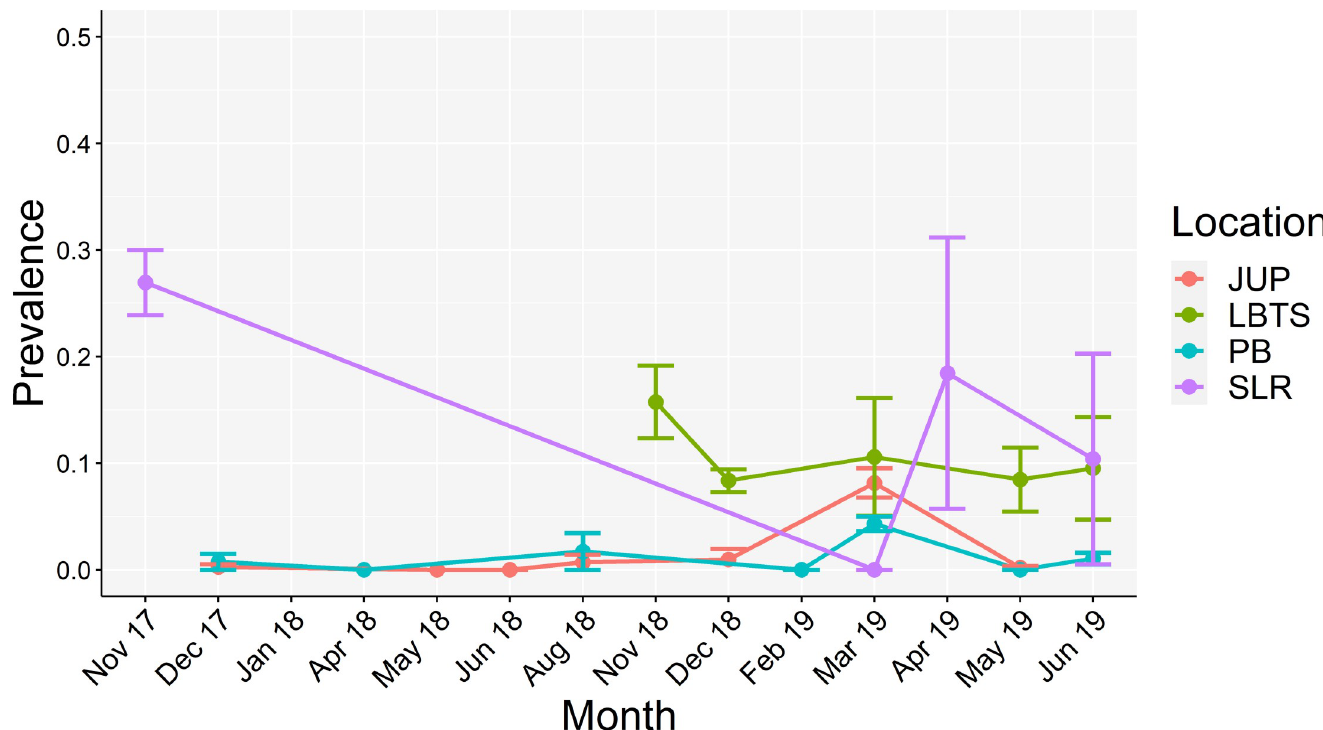
Fig 3. Mean SCTLD prevalence across all four locations (St. Lucie Reef, Jupiter, Palm Beach and Lauderdale-by-the-Sea). Points represent means; bars represent standard error.